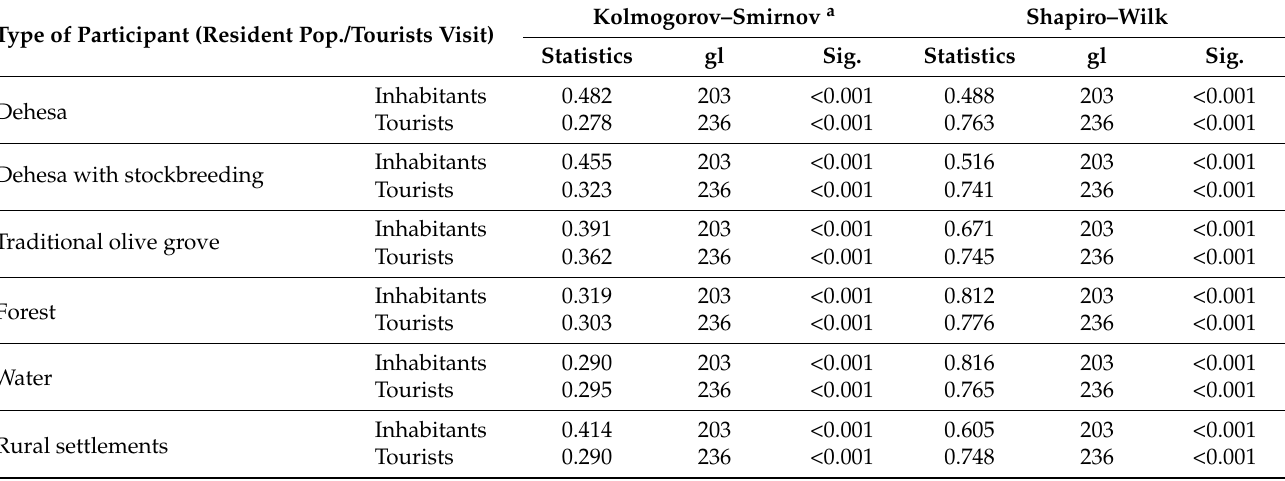
Table A2. Normality Test Showing the Adequacy of the Landscape for Tourism Activities.